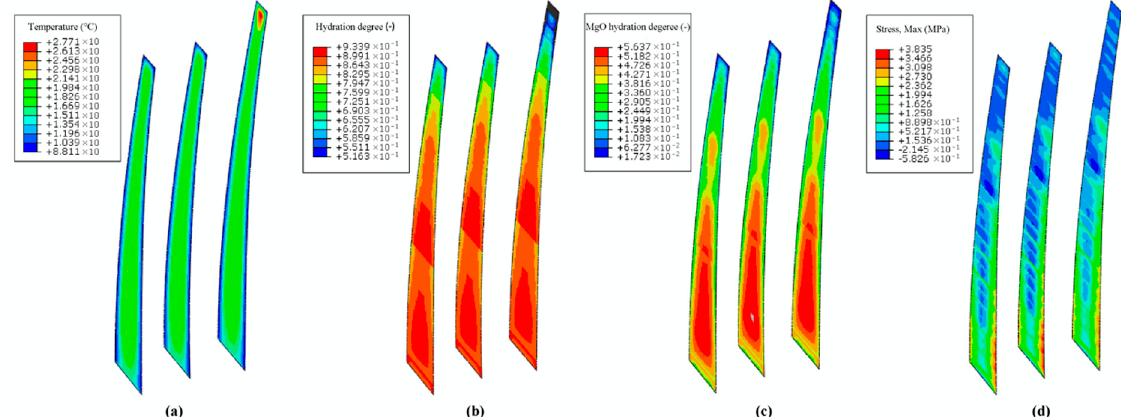
Figure 5. Coupled thermo-chemical-mechanical field computations on 1 June 2003. ( a ) Temperature ( ◦ C); ( b ) hydration